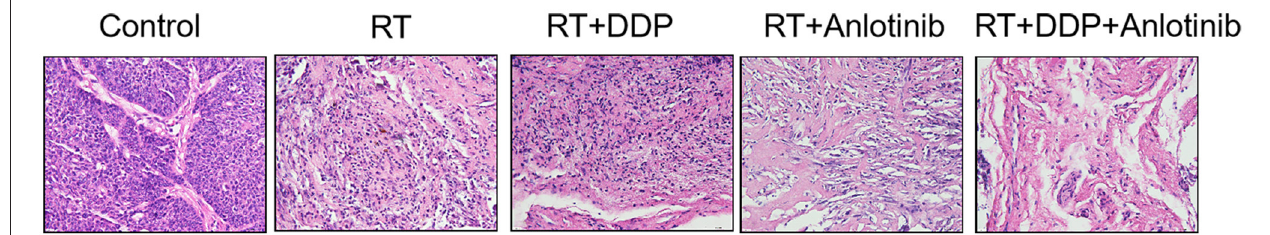
FIGURE 4 | Representative images during treatment showed that the structure of tumor tissue in control group remained normal with tumor and mesenchymal cells. The structure of other treatment groups was showed to be destroyed with various degrees in which anlotinib combined with chemoradiotherapy group exhibited the most significant change. The figure provided is a representative image, and other images are provided in the Supplementary Files. RT, radiation therapy; DDP, cisplatin.